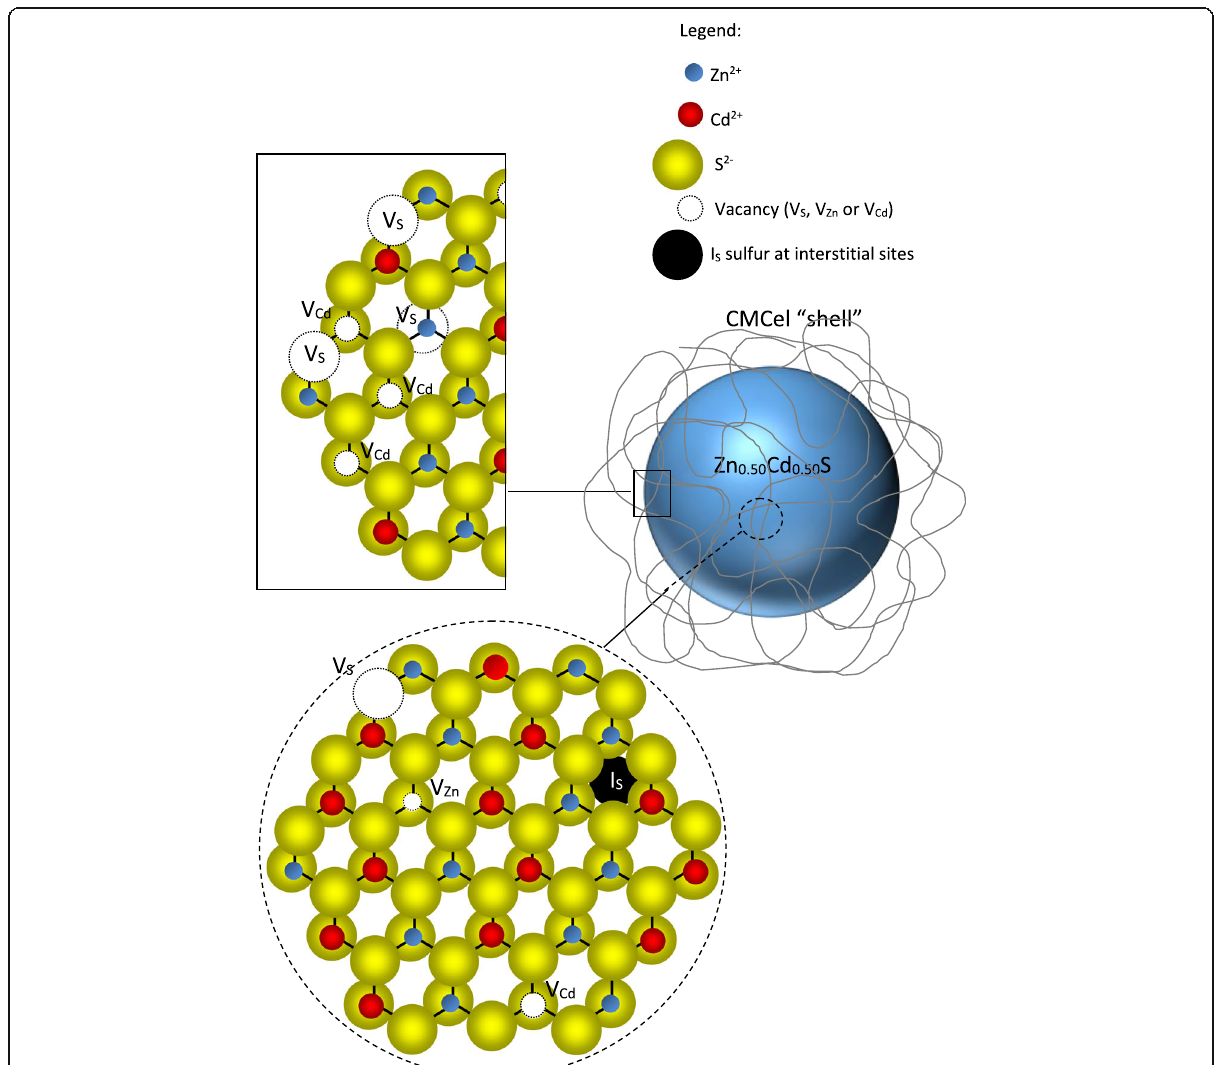
Fig. 8 Drawing of Zn 0.50 Cd 0.50 S quantum dot stabilized by CMC polymer; Schematic representation of Zn 0.50 Cd 0.50 S quantum dot (not to